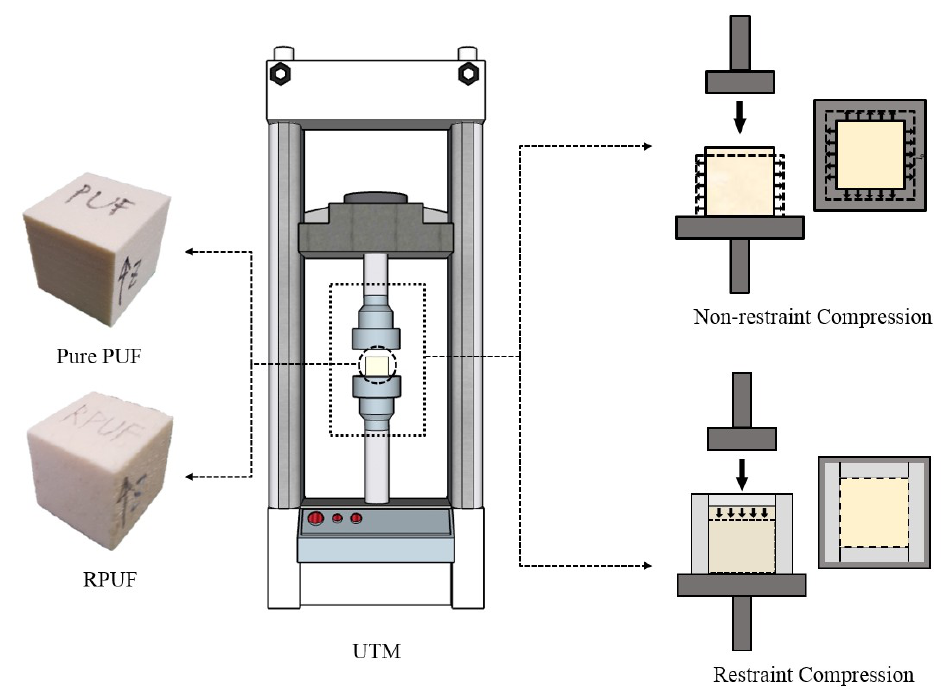
Figure 4. Mimetic diagram of test specimen and equipment.